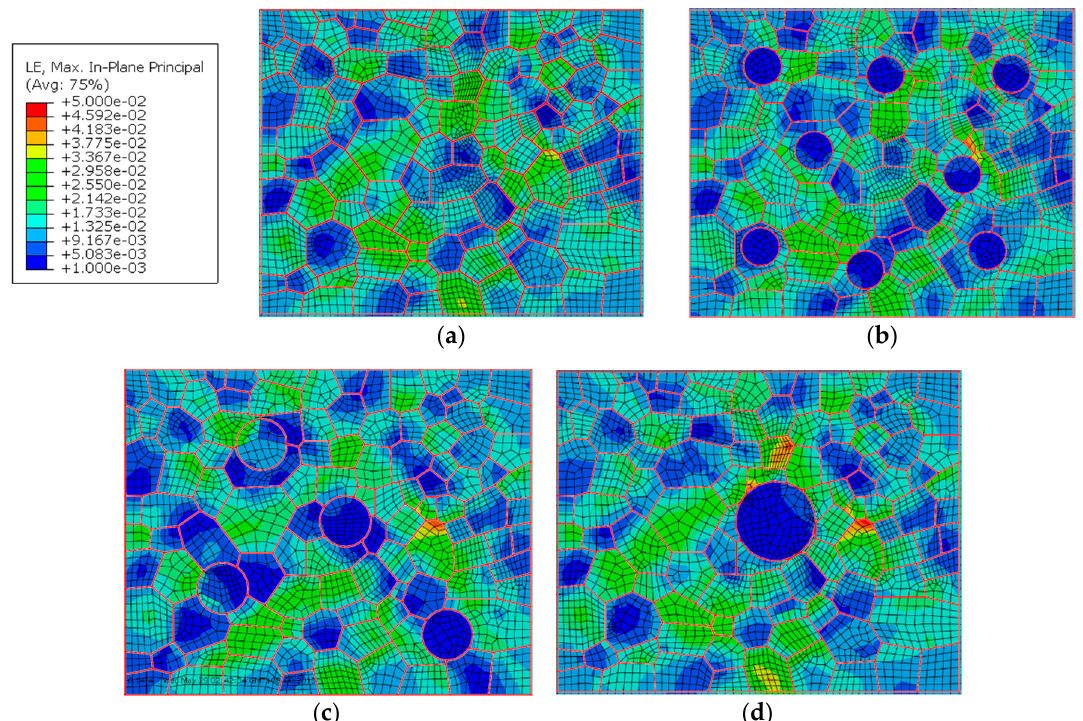
Figure 16. Stress distribution ( a ) without particle, and with ( b ) 5 μ m *8, ( c ) 6.3 μ m *4, and ( d ) 10 μ m *1 particles, MPa.